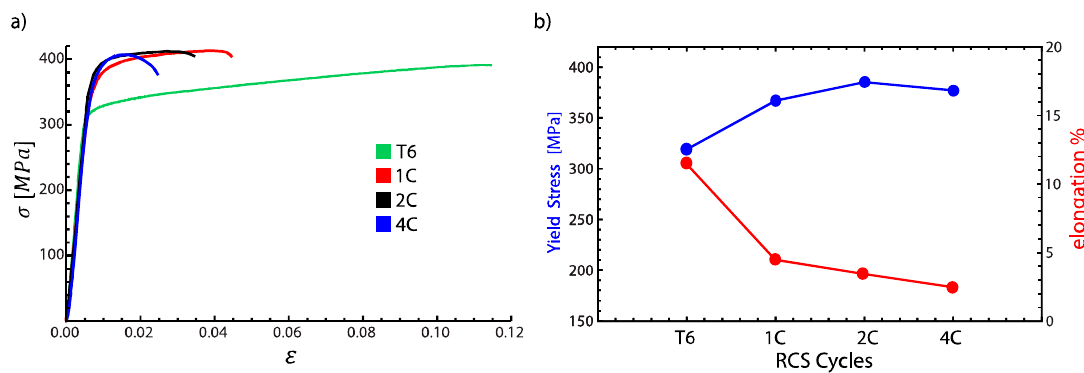
Figure 8. ( a ) Flow curve evolution through the RCS process, ( b ) Evolution of the yield strength as a function of the RCS cycles. In both plots, the reduction in ductility and the gain of yield strength (YS) due to the RCS process is observed.